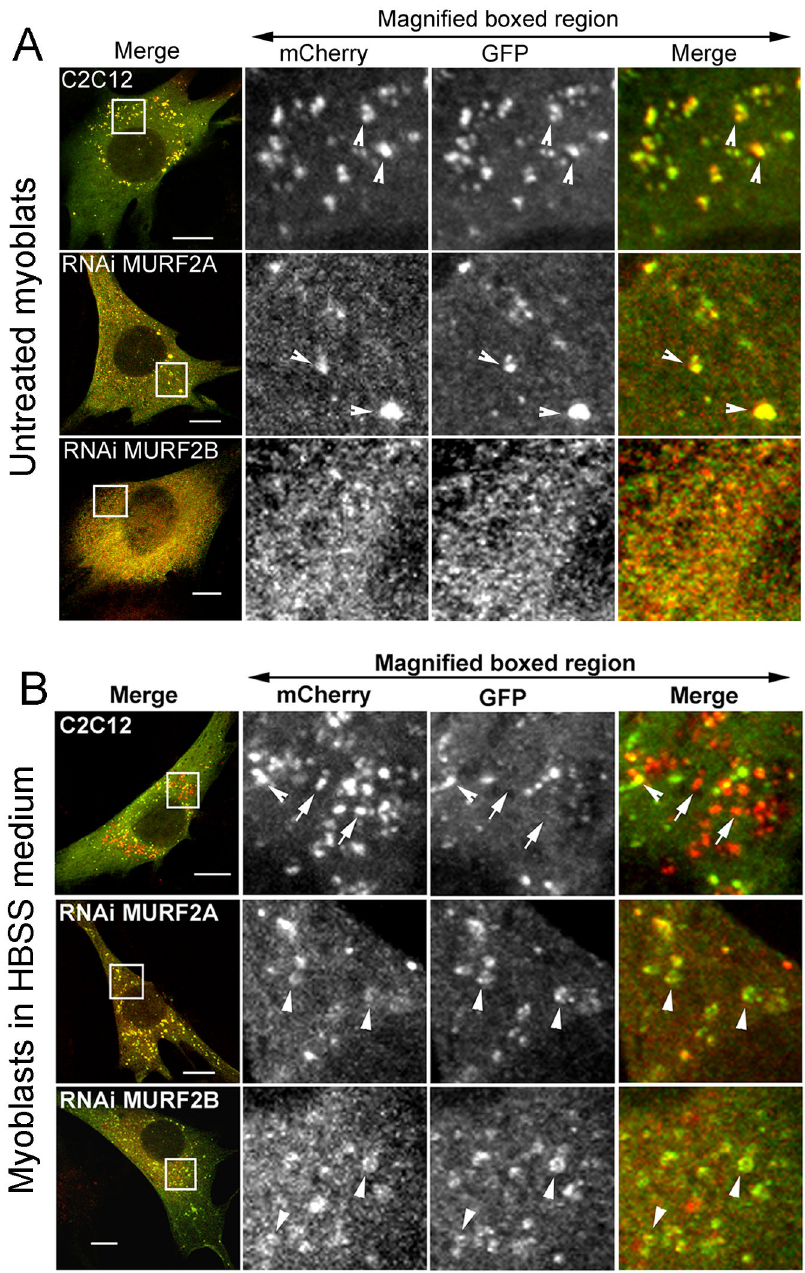
Figure 8. MURF2A activates the 20S proteasome and is implicated in p62 degradation. (A) Undifferentiated stable C2C12 and RNAi cell lines expressing the mCherry-GFP-LC3 protein were grown in 10% FCS and observed directly by confocal microscopy. In magnified regions, the yellow autophagosomes are indicated by empty arrowheads. (B) The same cell lines were kept in HBSS medium for 45 min and observed directly by confocal microscopy. Magnified regions show in C2C12 cells yellow autophagosomes (empty arrowheads) and red autolysosomes (arrows). In RNAi cells unconventional autophagic structures are indicated by arrowheads. Scale Bar: 10 µm. doi: 10.1371/journal.pone.0076140.g008 C2C12 and RNAi MURF2A myoblasts displayed low This activity was nearly abolished upon addition of MG132, chymotrypsin-like activity (Figure 9C, Diff. 0h), significant indicating that the RNAi MURF2B cells display high intrinsic increased activity was detected in RNAi MURF2B myoblasts. 20S activity. The same results were observed when the 20S